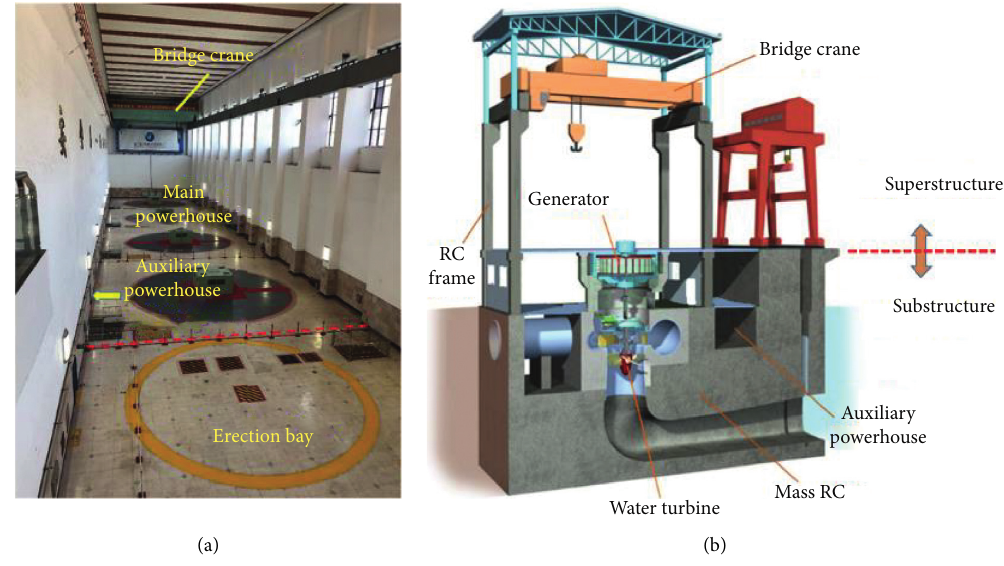
Figure 1: Basic components of an HP: (a) typical layout and (b) typical profile of the main